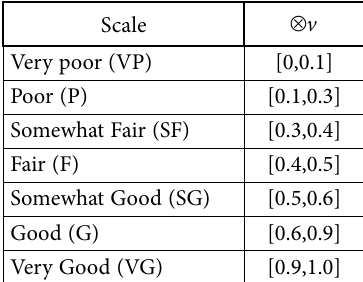
Table 5. The scale of attribute ratings v